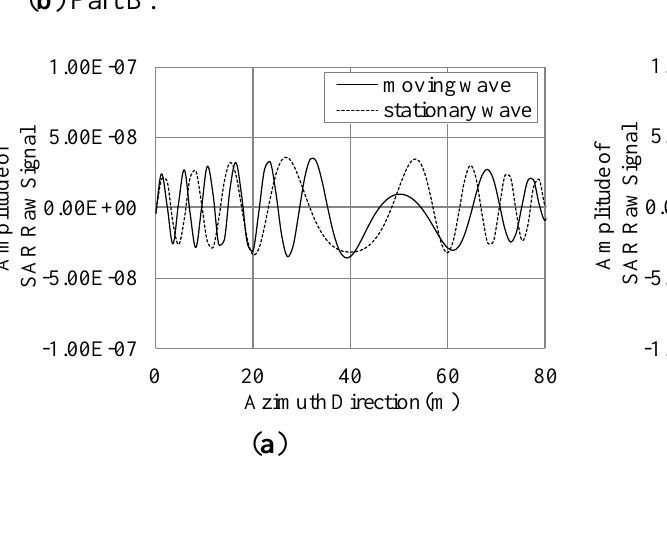
Figure 10. Simulated SAR raw signal of moving wave and stationary wave. ( a ) Part A; ( b ) Part